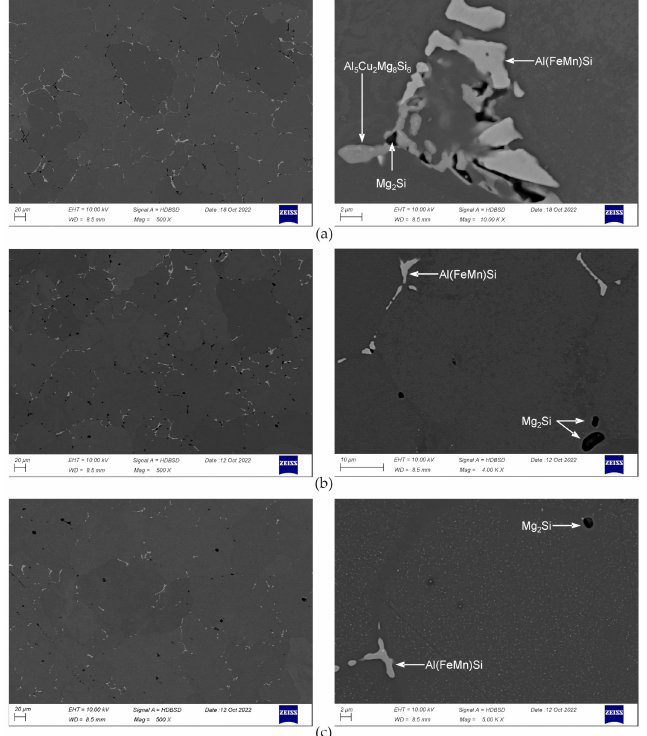
Figure 4. Microstructure of the alloy after heating to 475 ◦ C for 10 h and soaking: ( a ) at 475 ◦ C for 2 h; ( b ) at 475 ◦ C for 2 h + 530 ◦ C for 2 h; and ( c ) at 475 ◦ C for 2 h + 530 ◦ C for 2 h + 545 ◦ C for 8 h. After complete soaking, samples were water quenched.